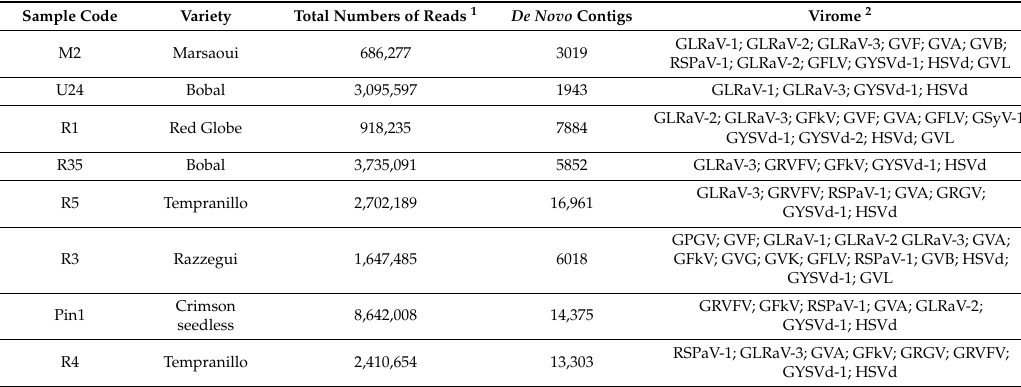
Table 2. High throughput sequencing (HTS)-determined virome of eight grapevine samples used to evaluate the exclusivity of the real-time qPCR